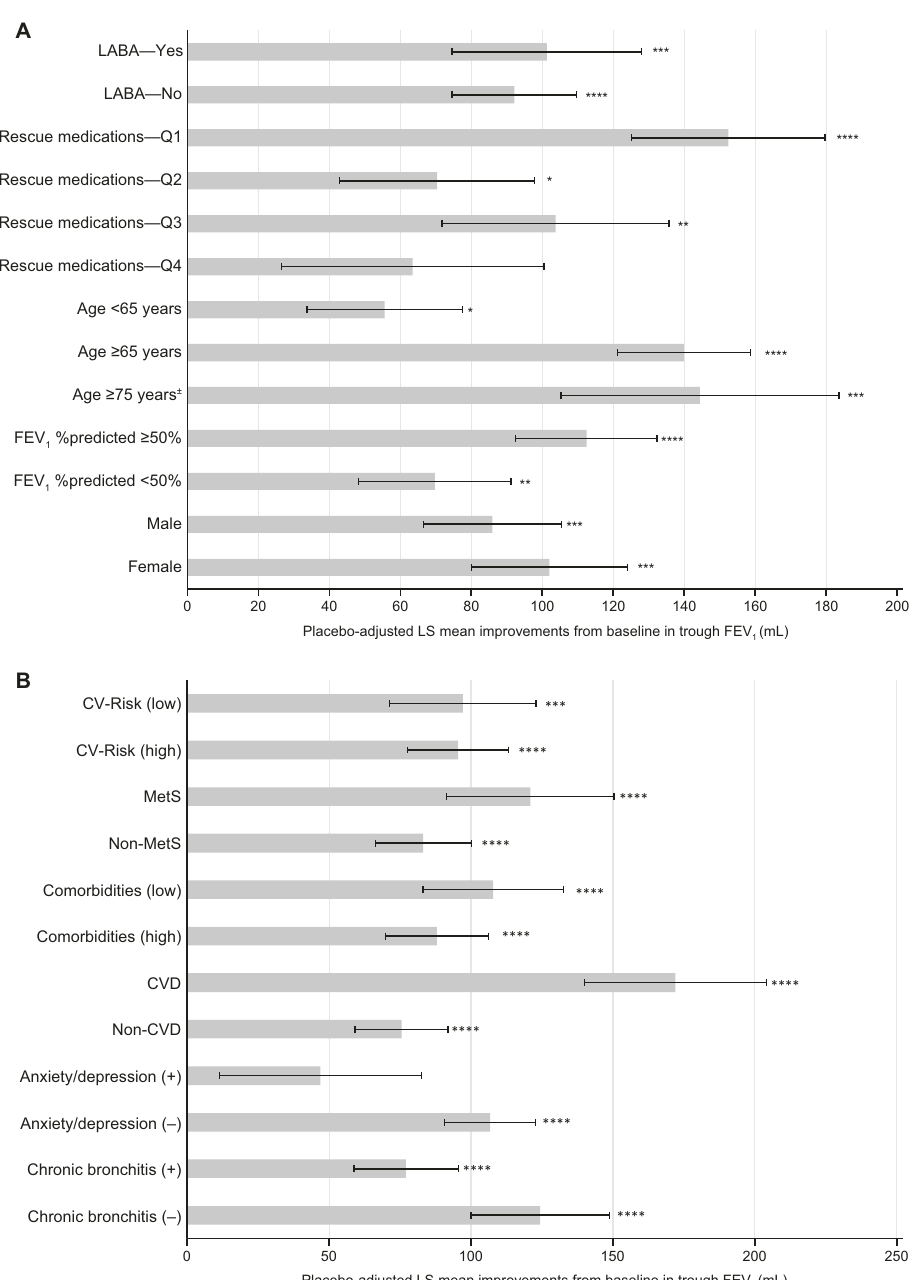
Fig. 2 Placebo-adjusted improvements from baseline in trough FEV1 (mL). Analysis by A baseline demographics and disease severity, and B comorbidities and chronic bronchitis at baseline, at 12 weeks. * p < 0.05; ** p < 0.01; *** p < 0.001; **** p < 0.0001 versus placebo, analyzed using a mixed model for repeated measures. Only placebo and GLY 25 µg dose from the GOLDEN 3 and 4 studies are shown. ± Subset of the ≥ 65 years group. CV cardiovascular, CVD cardiovascular disease, FEV 1 forced expiratory volume in 1 s, GLY nebulized glycopyrrolate, LABA long- acting β 2 -agonist, LS least squares, MetS metabolic syndrome, Q men (Fig. 4A and Supplementary Fig. 1). These data support the recommendations do not consider gender as a factor that may ef fi cacy of nebulized GLY in patients with COPD, independent of impact treatment choice. In GOLDEN 3 and 4, women represented gender. ~45% of patients 7 . At Week 12, nebulized GLY signi fi cantly It is estimated that ~35% of patients diagnosed with COPD in improved lung function and SGRQ total scores, irrespective of the US are ≥ 65 years of age 20 . Age is considered to be a risk factor gender (Figs. 2A, 3A, and Table 2) 19 . Further, the odds of being an SGRQ responder were signi fi cantly higher with GLY compared for COPD, with a progressive decline in lung function often with placebo, regardless of gender; the odds of being an observed with aging 1,21,22 . Physiological changes to the lungs Exacerbations of Chronic Pulmonary Disease Tool-Respiratory (e.g., reduction in strength of the respiratory muscles, change in Symptoms (EXACT-RS) responder ( ≥ 2-unit reduction in total score) thorax shape due to osteoporosis) and cognitive impairments were signi fi cantly higher with GLY compared with placebo only in (e.g., Alzheimer ’ s disease, dementia) due to aging, may impair